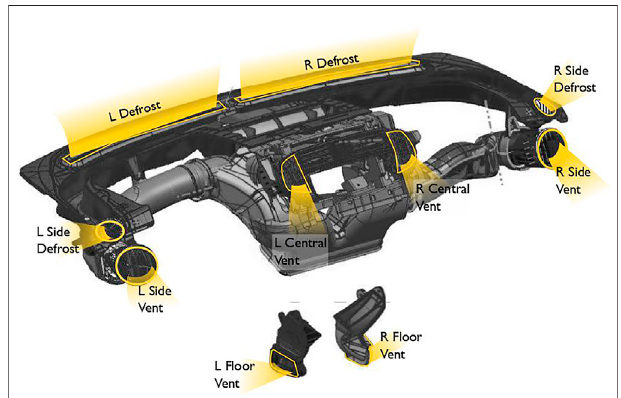
FIGURE 1 | Vent outlets on instrument panel and in footwell.